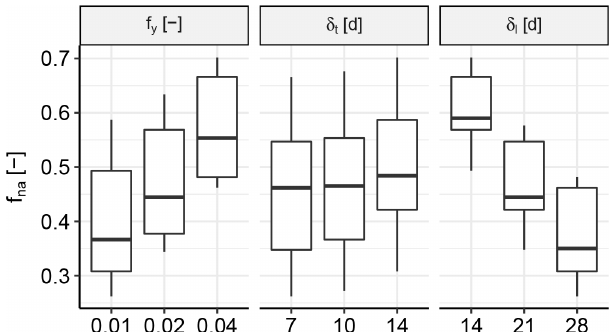
Figure 10. Sensitivity of f na , which is the fraction of missing val- ues in the observed descriptor matrix, to the three main settings used for the identification of events in Sect. 3. f y is the NR value window fraction, δ t is the NR time window, and δ l is the length of the global time windows.